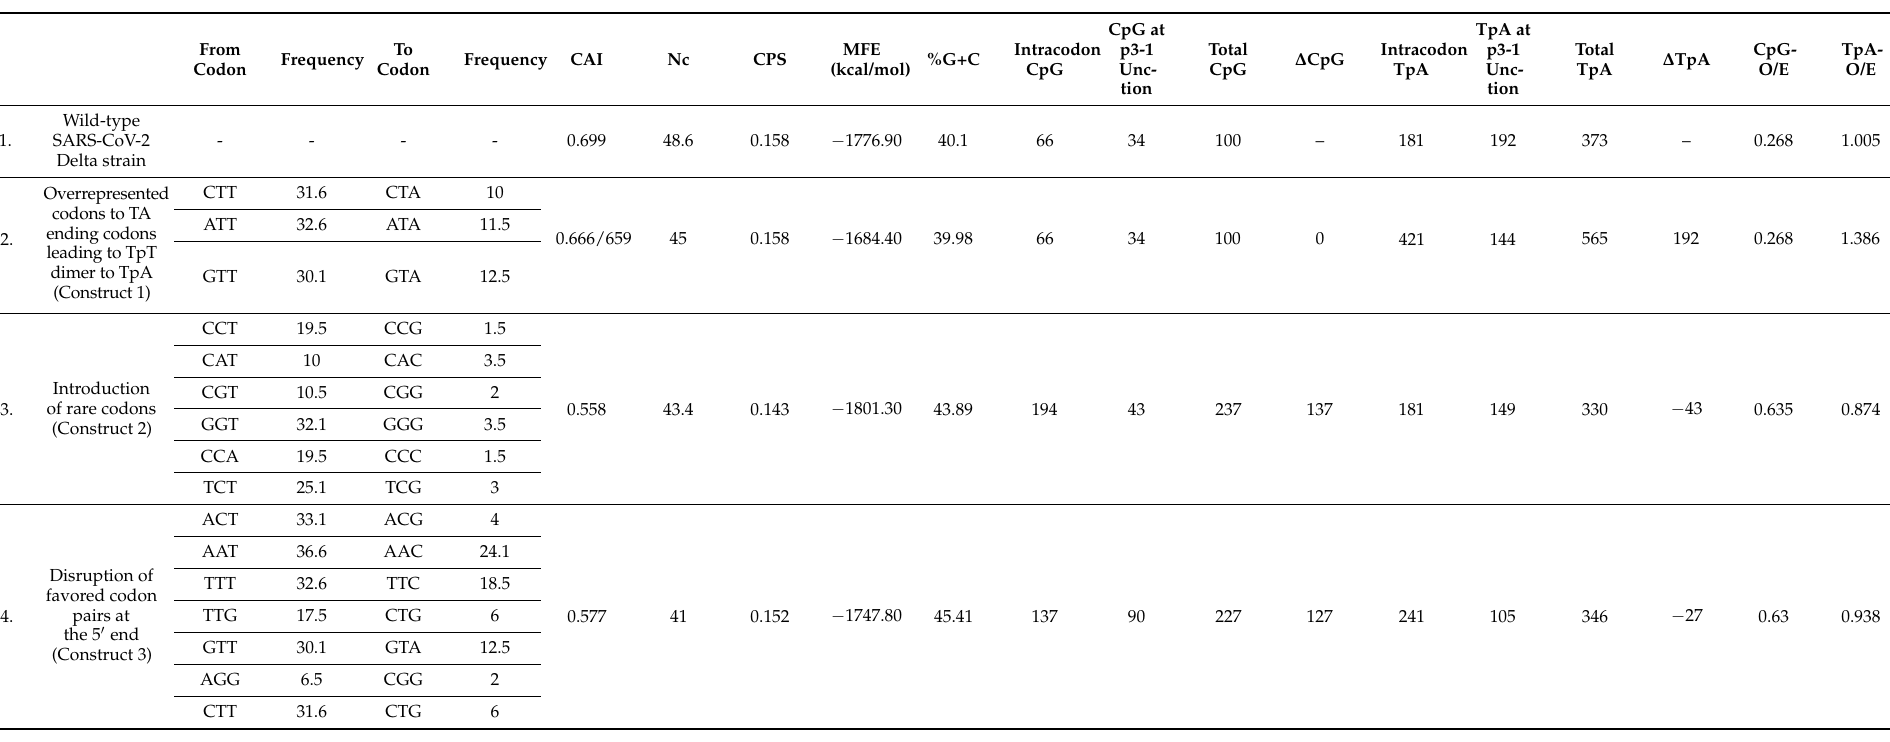
Table 7. Exhibition of codons recoded in the single construct having all four envisaged genes with intracodon and junctional CpG and TpA with O/E of CpG and